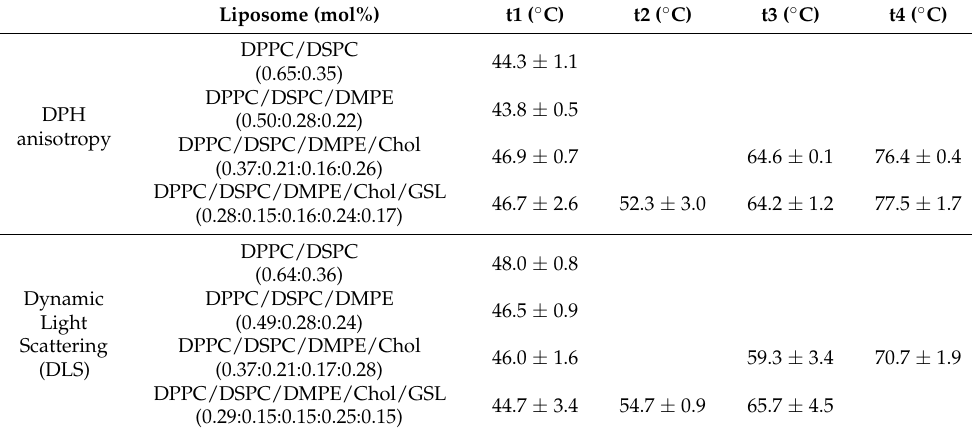
Table 1. Estimates of mean transition temperatures (T m , ◦ C) estimated for the different lipid systems using steady-state anisotropy fluorescence and DLS readings. Values are relative to mean ± SD of independent experiments ( n =